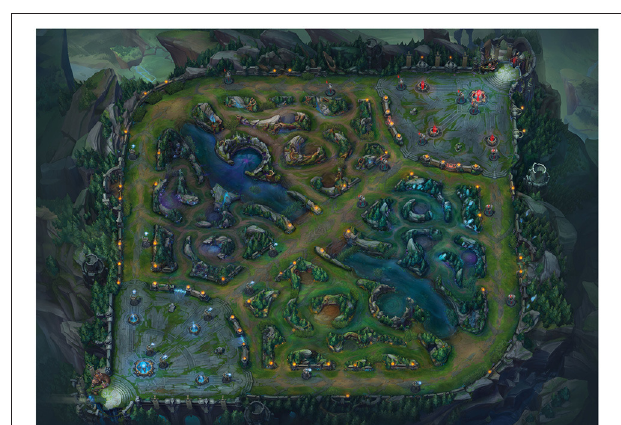
FIGURE 2 | The league of legends game map. On the bottom left is the base for the green team, on the top right is the base for the red team. These are linked by three lanes, and the areas between the lanes are the jungles. The lanes contain towers that fire at enemy players and must be destroyed to advance toward the enemy base. Image reproduced with permission from Riot Games Inc. This image is copyrighted to Riot Games Inc.